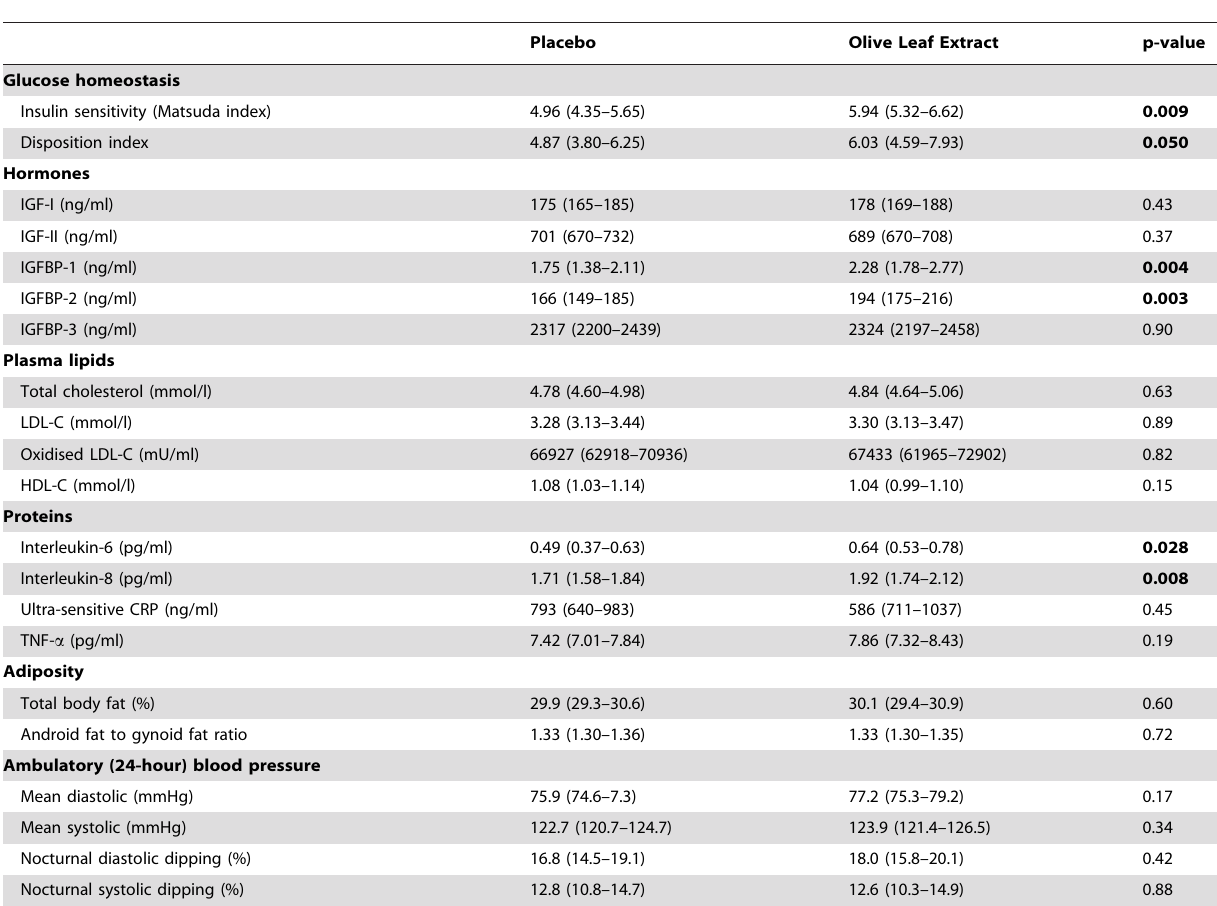
Table 4. Outcomes following a 12-week supplementation with olive leaf extract or placebo.